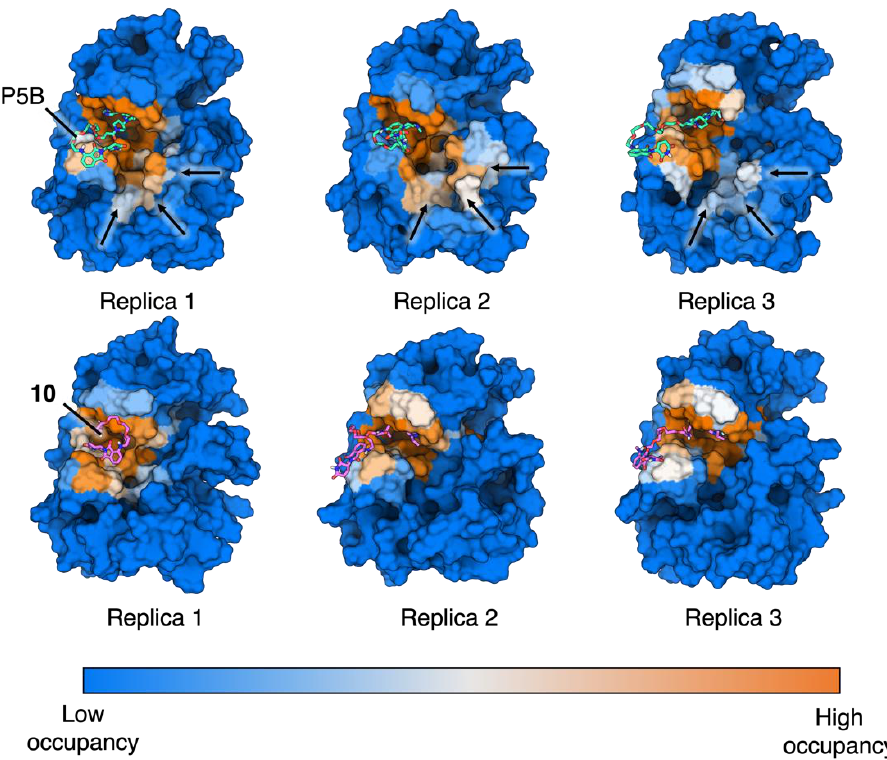
Figure 9. Occupancy of ligand–protein contacts along MD productions, mapped on the surface of BRAF. Occupancy is defined as the normalized number of MD frames in which atoms of the ligand are at a distance equal or lower than 4 Å from protein atoms. Occupancy is shown as a range of colors spanning from blue (low occupancy) to orange (high occupancy) areas. Black arrows highlight areas of BRAF V600E which were accessed by P5B but not by 10 . Protein is represented as surface, ligand is depicted as sticks and labelled.